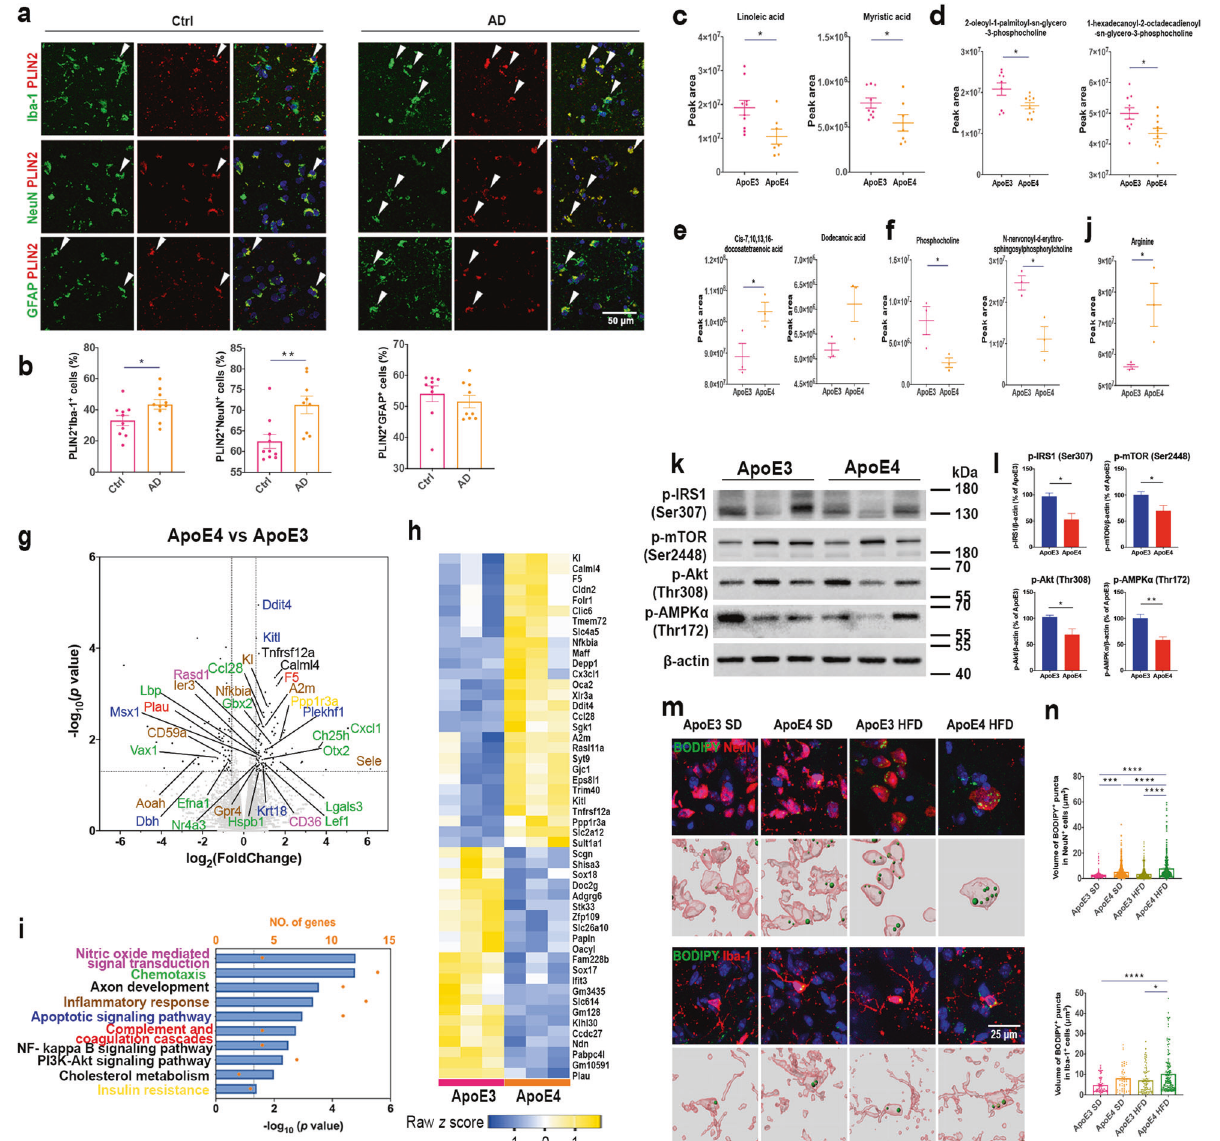
Fig. 1 APOE4 allele led to lipid metabolism dysfunction in neurons and microglia. a Representative immuno fl uorescent images of PLIN2 + lipid droplets, Iba-1 + microglia, NeuN + neurons, and GFAP + astrocytes in the cerebral cortex of normal and ApoE4 AD individuals. b Mander ’ s colocalization coef fi cient quanti fi cation of PLIN2 and Iba-1, NeuN, or GFAP. c , d Signi fi cantly changed metabolites in the peripheral plasma of ApoE3 and ApoE4 mice. e , f Signi fi cantly changed metabolites in ApoE3 and ApoE4 mouse brains. g Volcano plot showing differentially expressed genes in ApoE3 and ApoE4 mouse brains. The dotted lines indicate the p < 0.05 and |fold change| > 1.5 cutoffs (two-sided Student ’ s t test, Benjamini ‒ Hochberg FDR). Genes enriched in pathways are colored in the same color in ( i ). h Heatmap showing the top 50 differentially expressed genes between ApoE3 and ApoE4 mice. i Enrichment pathway analysis of genes differentially expressed between ApoE3 and ApoE4 mouse brains. j Arginine levels in ApoE3 and ApoE4 mice were analyzed by MS. k , l Immunoblotting and quanti fi cation showing p-IRS1 (Ser307), p-mTOR (Ser2448), p-Akt (Thr308), and p-AMPK in ApoE3 and ApoE4 mouse brains. m Immuno fl uorescent images in the upper panel show brain cortical sections of ApoE3 and ApoE4 mice fed a SD or HFD costained for BODIPY + NeuN + or BODIPY + Iba-1 + cells. The lower panel shows 3D reconstructions of BODIPY + NeuN + or BODIPY + Iba-1 + cells. n Quanti fi cation of BODIPY + NeuN + and BODIPY + Iba-1 + cell numbers in the cerebral cortex. n = 3 mice per group. Experiments on primary neurons were performed three times in technical triplicates. Statistical tests: two-sided Student ’ s t test ( b – f , j , l ). One-way ANOVA followed by Tukey ’ s post hoc test ( n ). Data represent the mean ± s.e.m. * p < 0.05, ** p < 0.01, *** p < 0.001, **** p < 0.0001. Scale bars, 50 μ m ( a ); 100 μ m ( p